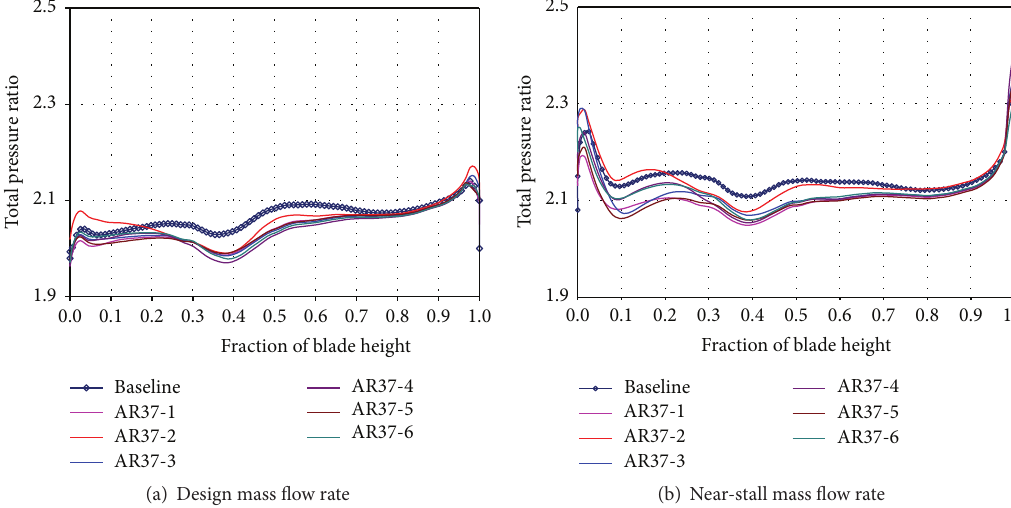
pressure ratio becomes higher throughout the blade